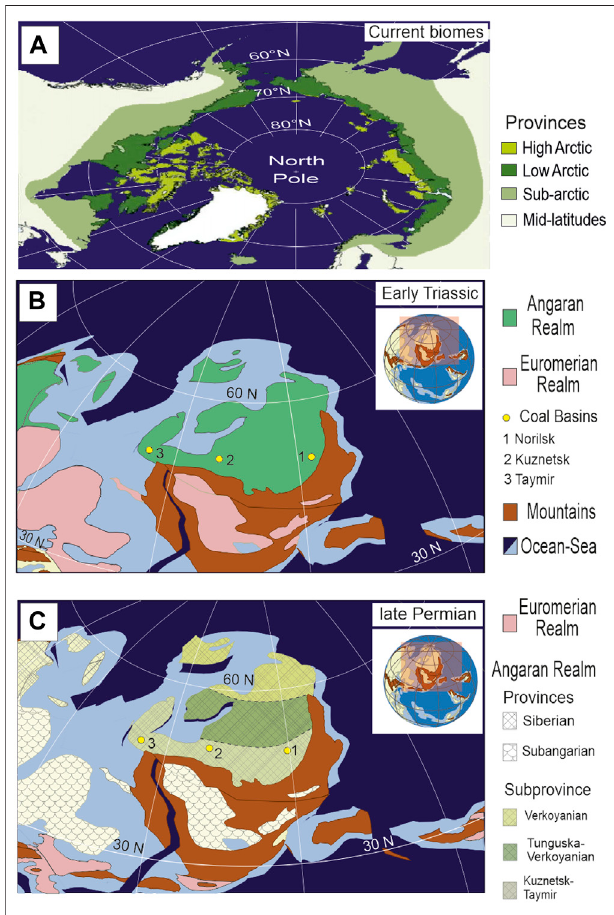
FIGURE5| PhytogeographicmapsofcircumpolarArcticareaduringthe late Permian and Early Triassic compared with the recent phytogeography. The maps are compiled and modi fi ed from Krassilov (2003), Dobruskina and Durante (2004) and Elias (2020). The phytogeographic differentiation and the late Permian climate are quite similar with the current Arctic provincial differentiationandclimate (A,C) ,althoughtherecentprovincesarelatitudinally narrower than during the late Permian. The phytogeographic differentiation duringtheclimaticoptimumintheEarlyTriassic (B) wasstronglyreduced,and only Realms with no provinces are recognized at that